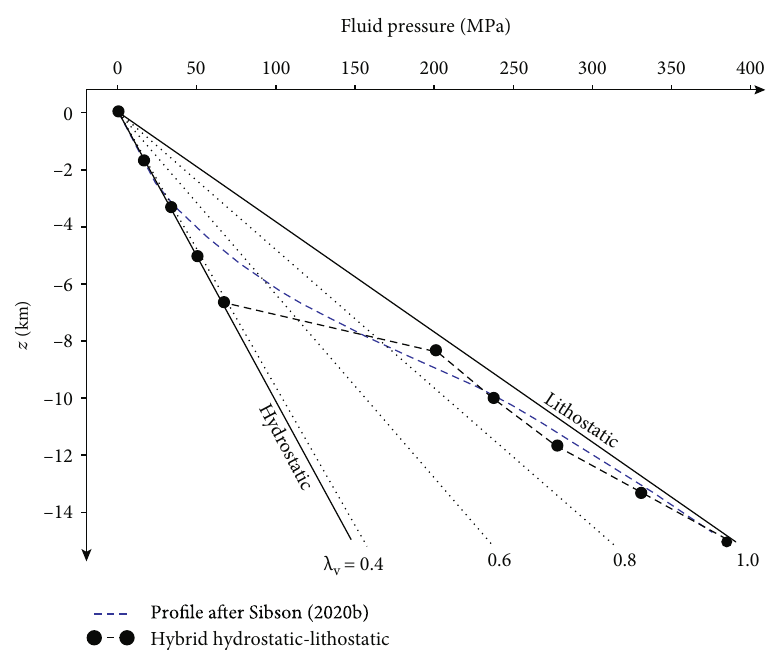
Figure 5: Pro fi les of fl uid pressure versus depth within the crust depending on the pore- fl uid factor, λ line are taken from the M2 reference model. The blue dashed line assumes a smooth progression from hydrostatic towards lithostatic pressure as permeability steadily reduces with increasing depth from Sibson [86]. Rock density values used to compute the curve can be referred in Table